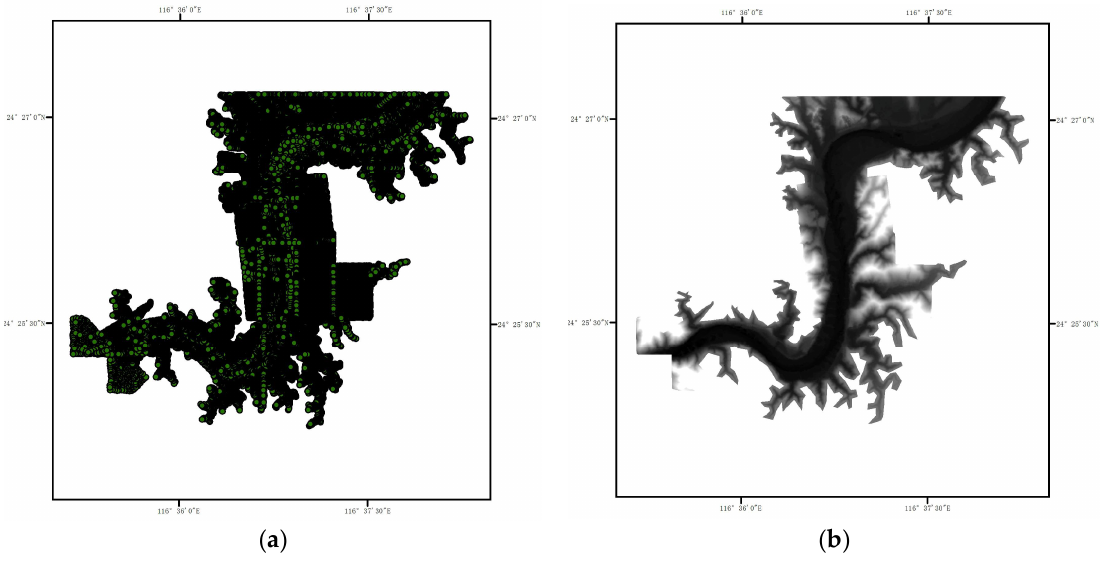
Figure 7. The process of elevation points to DEM. ( a ) The shape-file of elevation points; and, ( b ) The DEM file of raster obtained form ( a